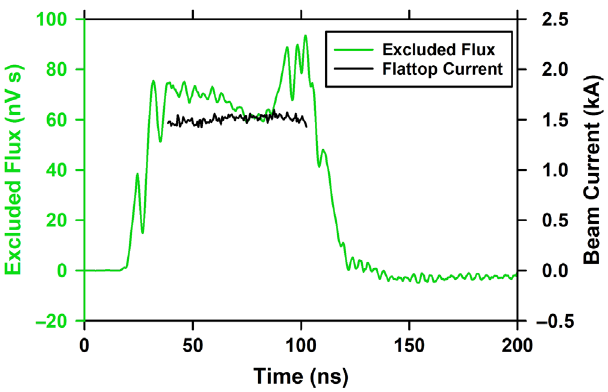
FIG. 7. Excluded flux (green curve) and flattop beam current (black curve). The data for this plot were from shot 37858 corrected for a background shot 37853.